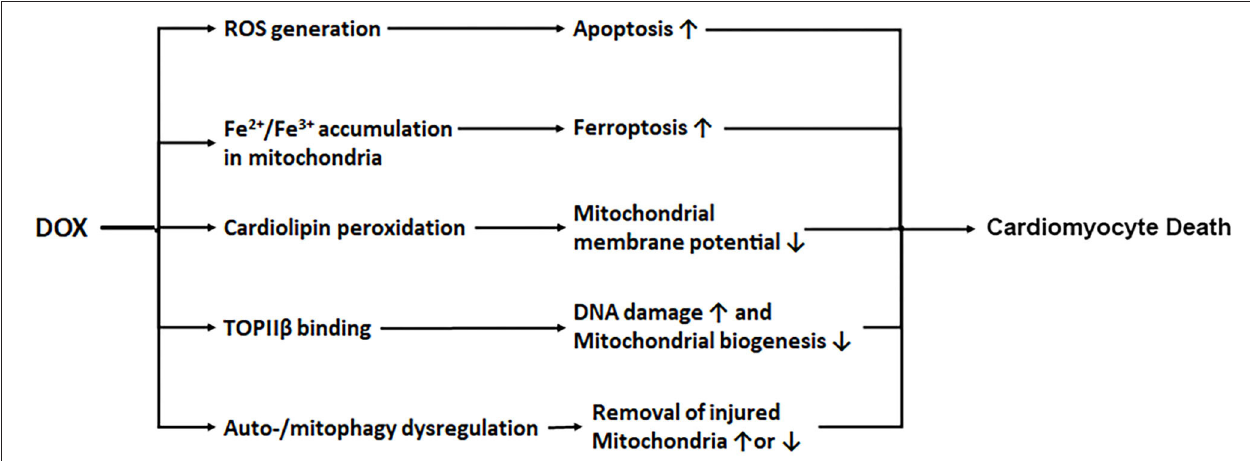
FIGURE 1 | DOX induces cardiotoxicity via multiple mechanisms. DOX enters mitochondria triggering increased production of ROS, iron accumulation, cardiolipin peroxidation, and mitochondrial injury. DOX also binds to topoisomerase II β (TOPII β ), resulting in DNA damage and reduced mitochondrial biogenesis. In addition, DOX causes autophagy/mitophagy dysfunction, leading to either reduced or excessive elimination of injured mitochondria, worsening cardiac